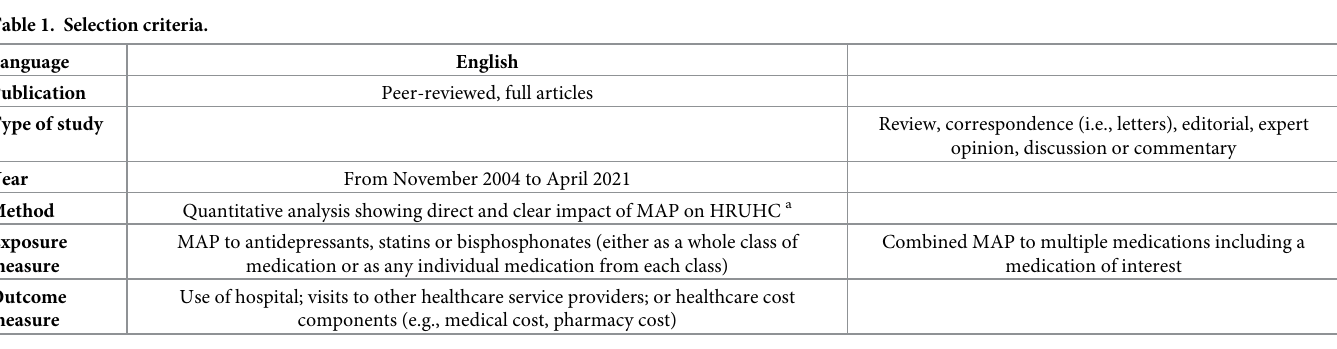
Table 1. Selection